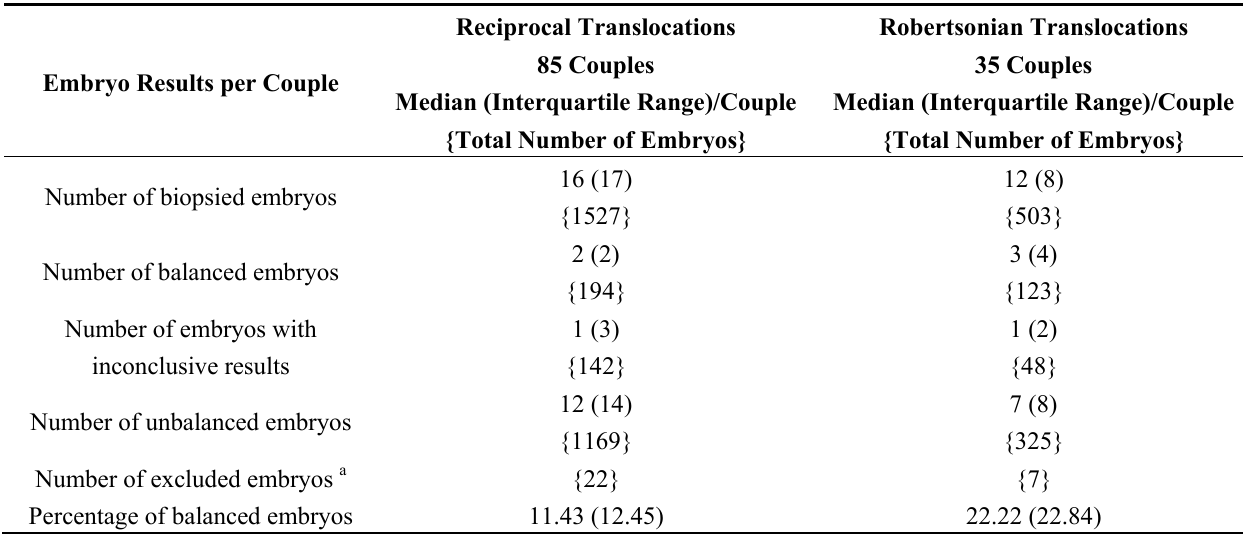
Table 2. Results of the preimplantation genetic diagnosis (PGD) analysis of 120